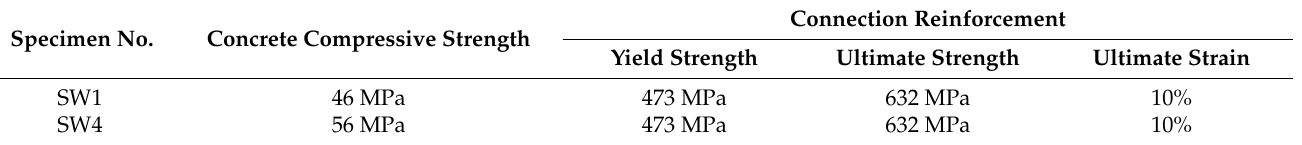
Table 2. Measured material properties of SW1 and SW4